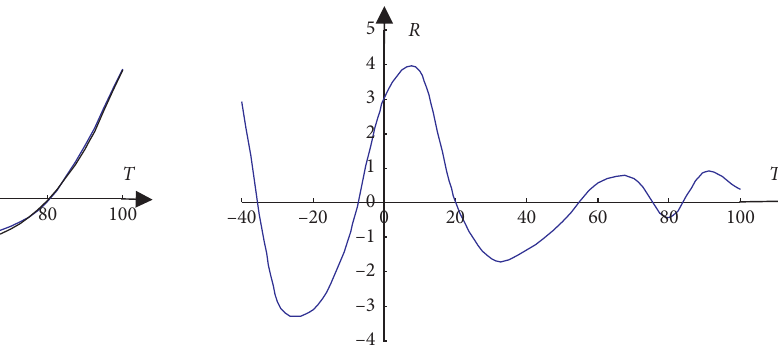
Figure 5: The function model fitting of frequency error. Figure 6: The residual error’s